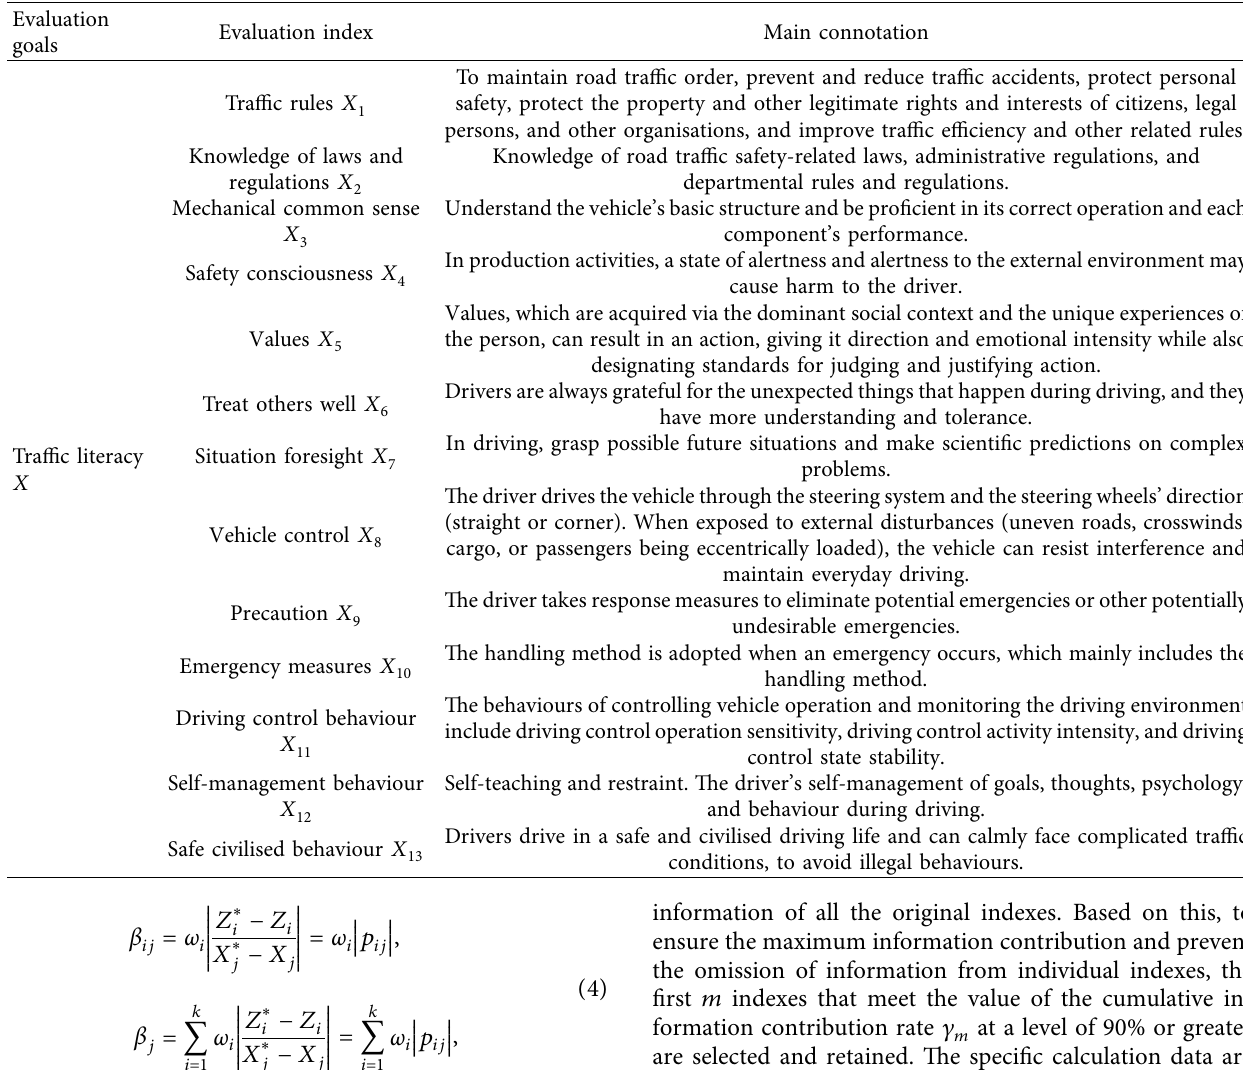
Table 1: Structure of the evaluation indexes for transportation